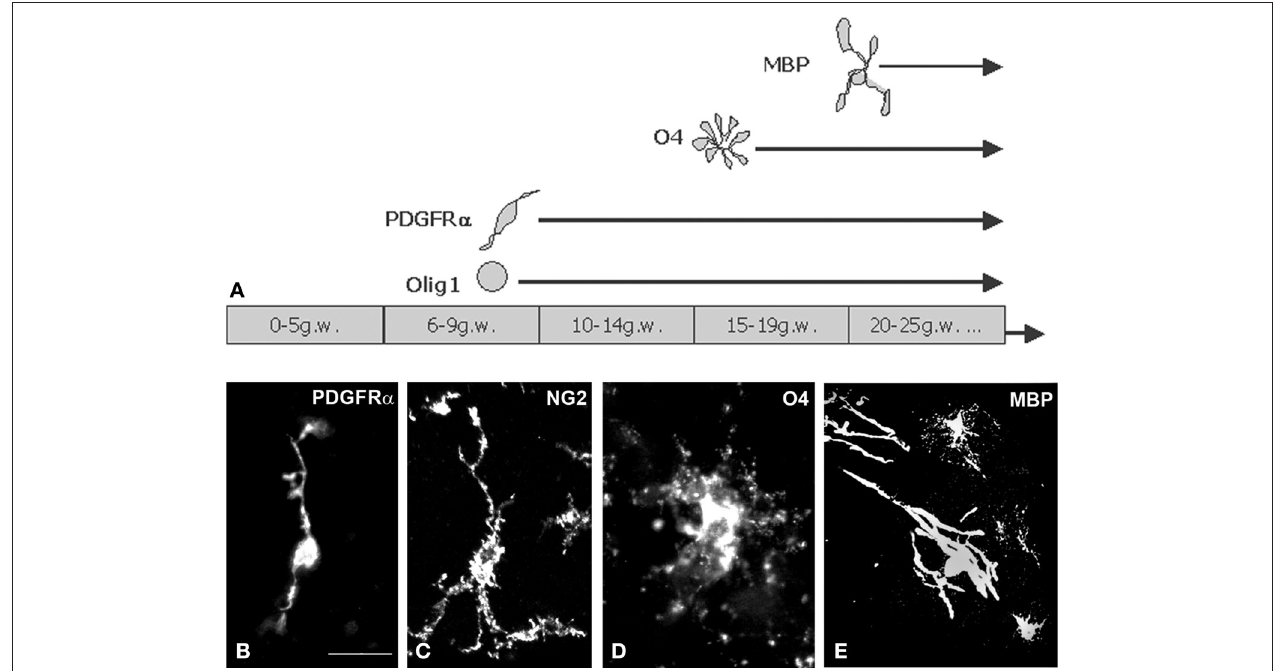
FIGURE 2 | Time-course of various oligodendrocyte lineage markers expression in the human forebrain. (A) Early oligodendrocyte precursor cells appear around 9 gw in the ganglionic eminence, and during the next few weeks spread to cortex. Late oligodendrocyte precursors appear in modest numbers around 15 gw. MBP + cells with typical oligodendrocyte morphology are very sparse at midgestation, but their population steadily enlarges. The fi rst myelin sheaths can be demonstrated by MBP staining at 18 gw in thalamus, and